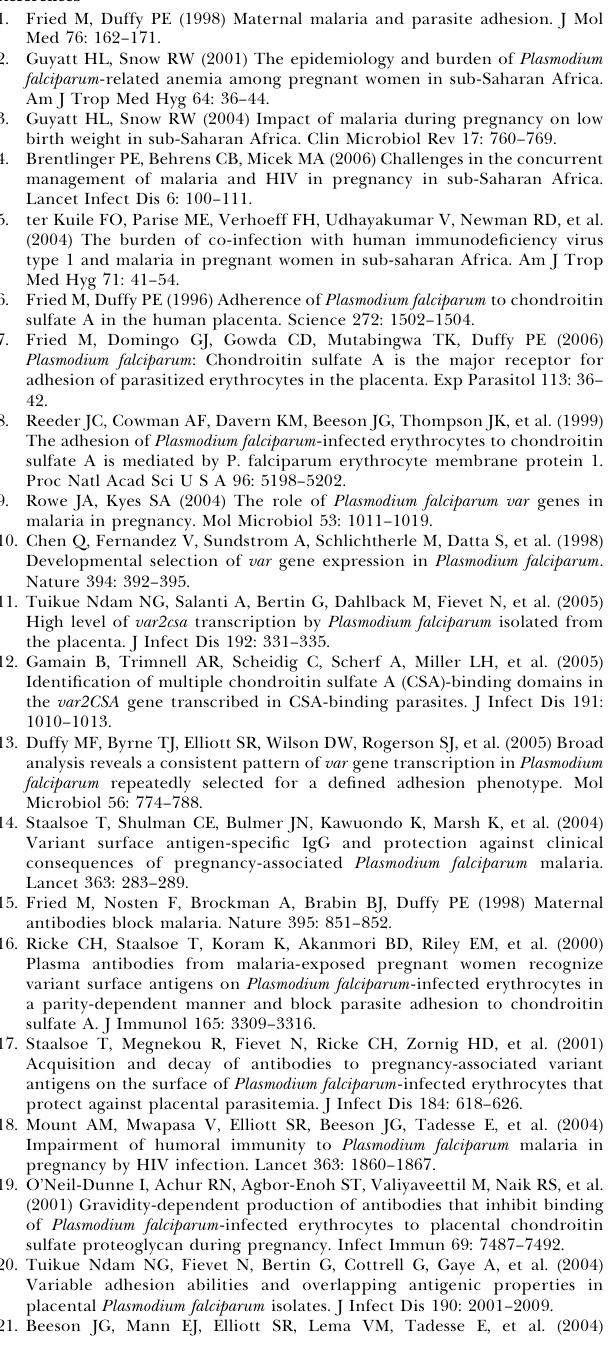
Figure S1. Comparison of Phagocytosis of Plasma Opsonized CSA- Binding PEs between Human Monocytes and CD36 (cid:2) / (cid:2) Murine Macrophages Phagocytic index of CSA-binding PEs opsonized with plasma from non-immune (NI), malaria-exposed PG or malaria-exposed MG women by human monocytes (A) or Cd36 (cid:2) / (cid:2) murine macrophages (B). The higher baseline phagocytosis observed with human mono-